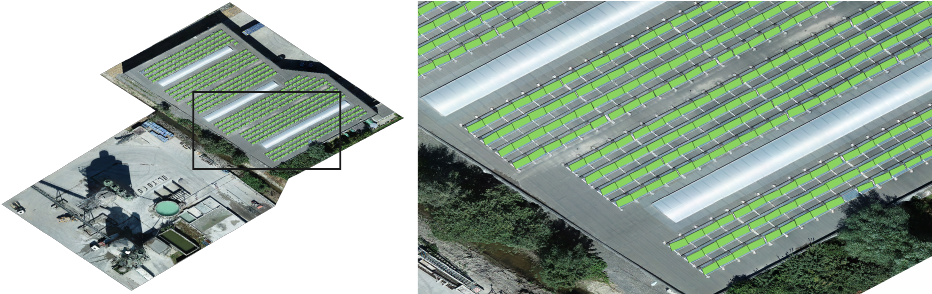
Figure 1. Example of solar panel detection on a Belgian, rooftop-based PV site ( left ) and a zoomed in version ( right ). The solar panel detection is used to reduce the search window for the anomaly detection